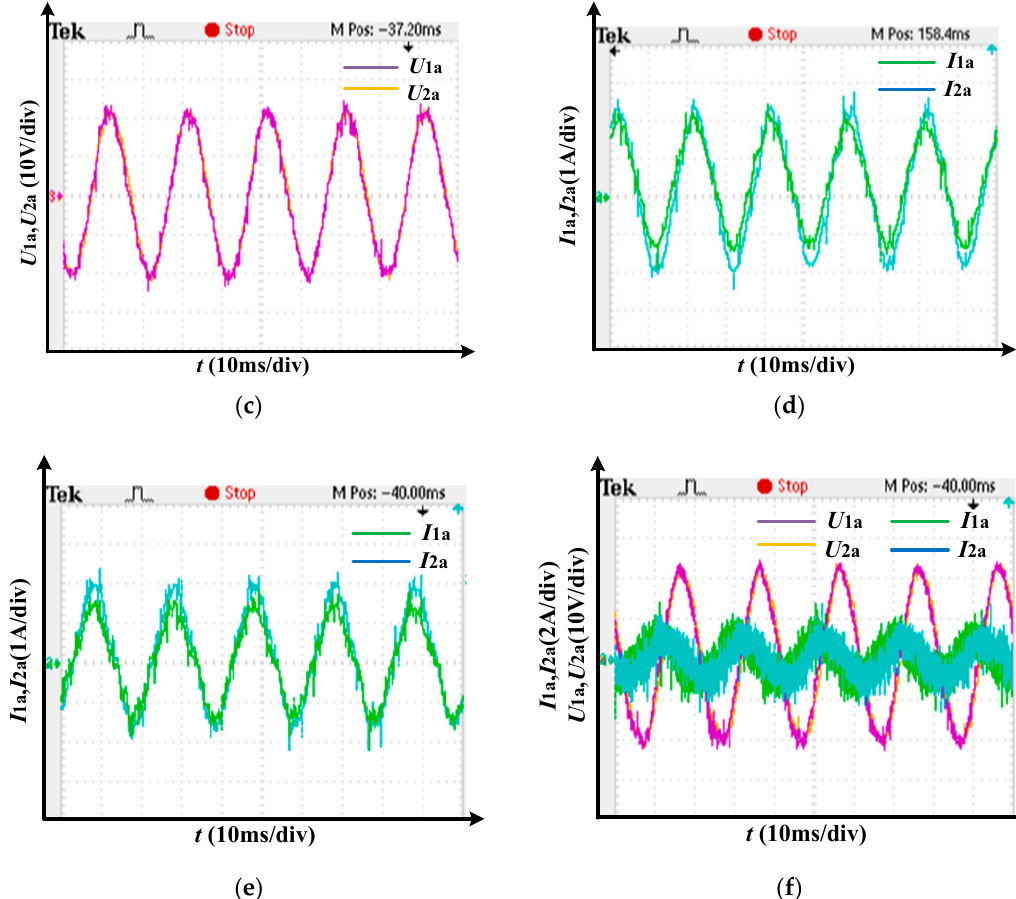
Figure 14. Converter parallel strategy experimental results: ( a ) initial state output voltage; ( b ) the transient process of the output voltage; ( c ) steady state output voltage; ( d ) the transient process of the output current; ( e ) steady state output current. ( f ) Output voltage and current of two converters after stabilization.